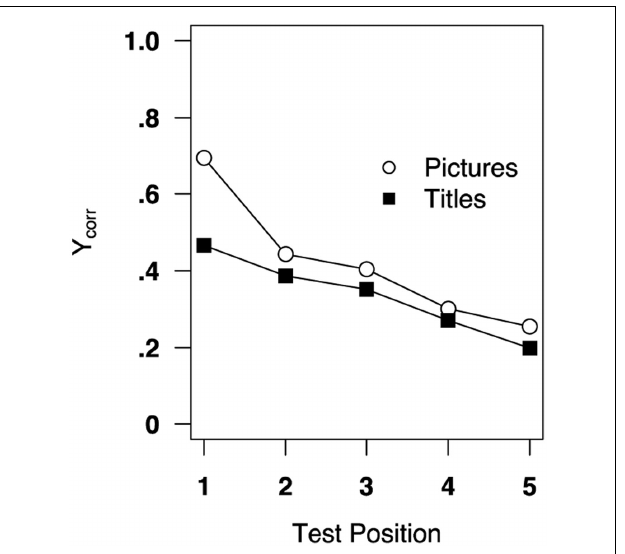
FIGURE 6 | Recognition test of five pictures shown in RSVP for 173ms/picture; the test used pictures or titles. Guessing-corrected results (see text footnote 1) are shown as a function of relative position in the recognition test, which included five new pictures (distractors). From Potter et al.